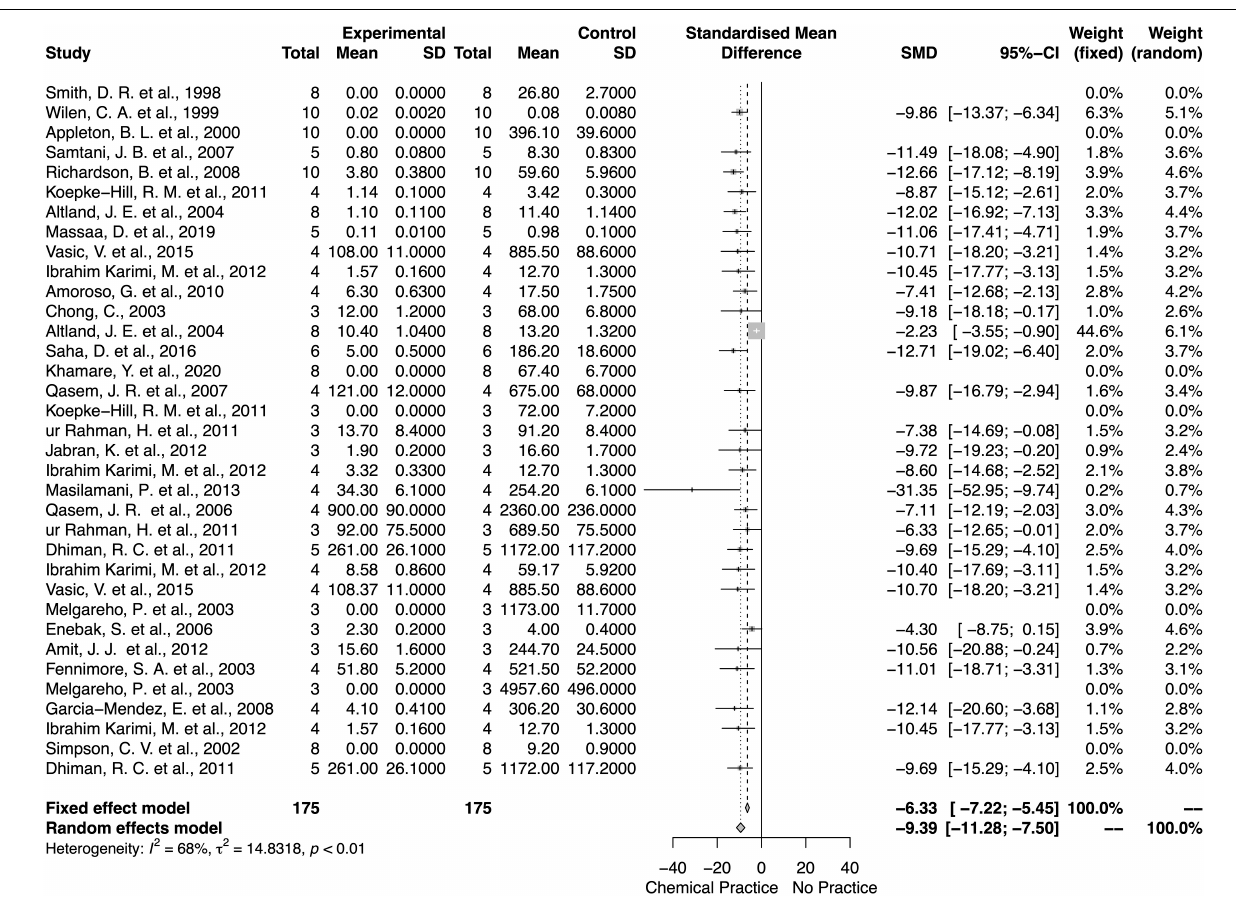
FIGURE 6 | Meta-analysis for the chemical weed control method on weed